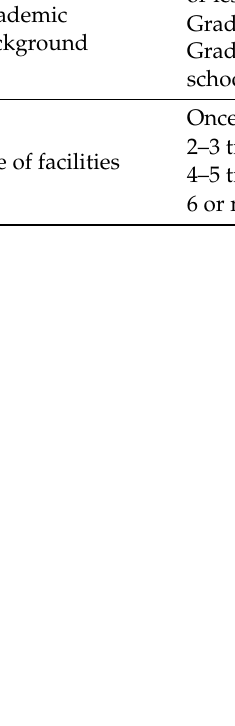
Table 7. Differences in reuse intention according to demographic